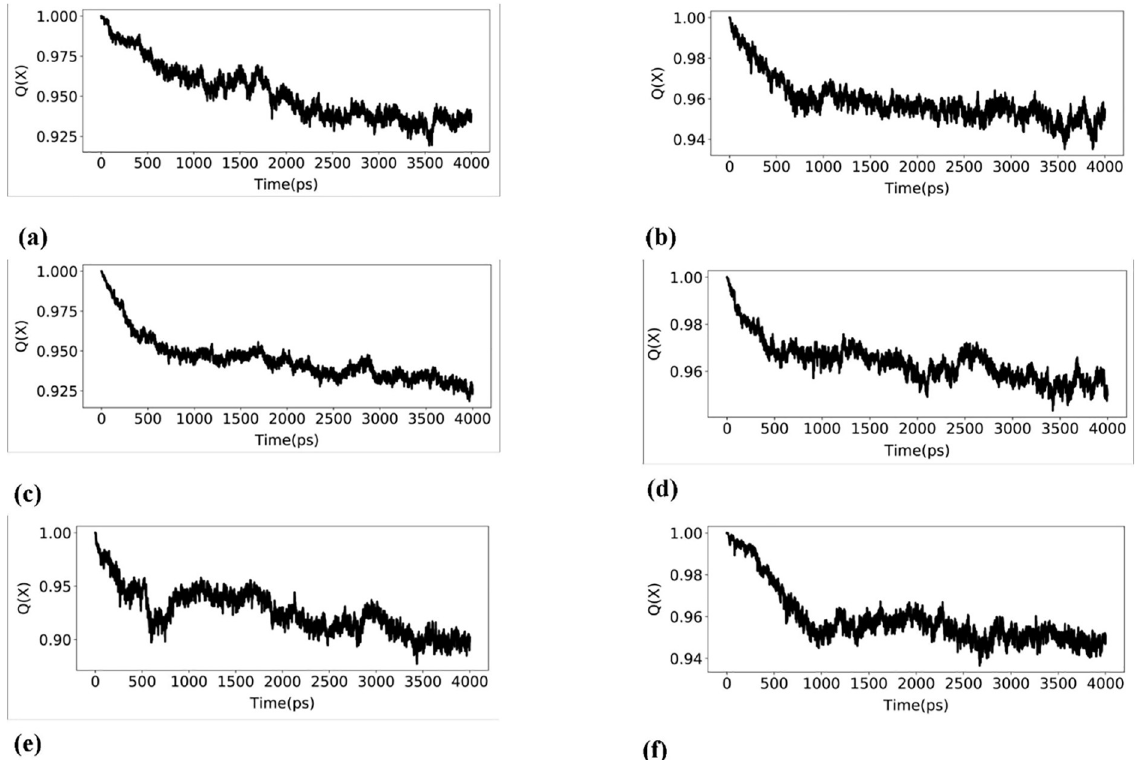
Fig 5. Plot of native contacts versus time (ps) (Q) ( a ) CDK-2_cmpd44 ( b ) CDK-6_cmpd59 ( c ) Topoisomerase-I_cmpd37 ( d ) Topoisomerase- II_cmpd37 (e ) Bcl-2_cmpd46 ( f ) VEGFR-2_cmpd37.